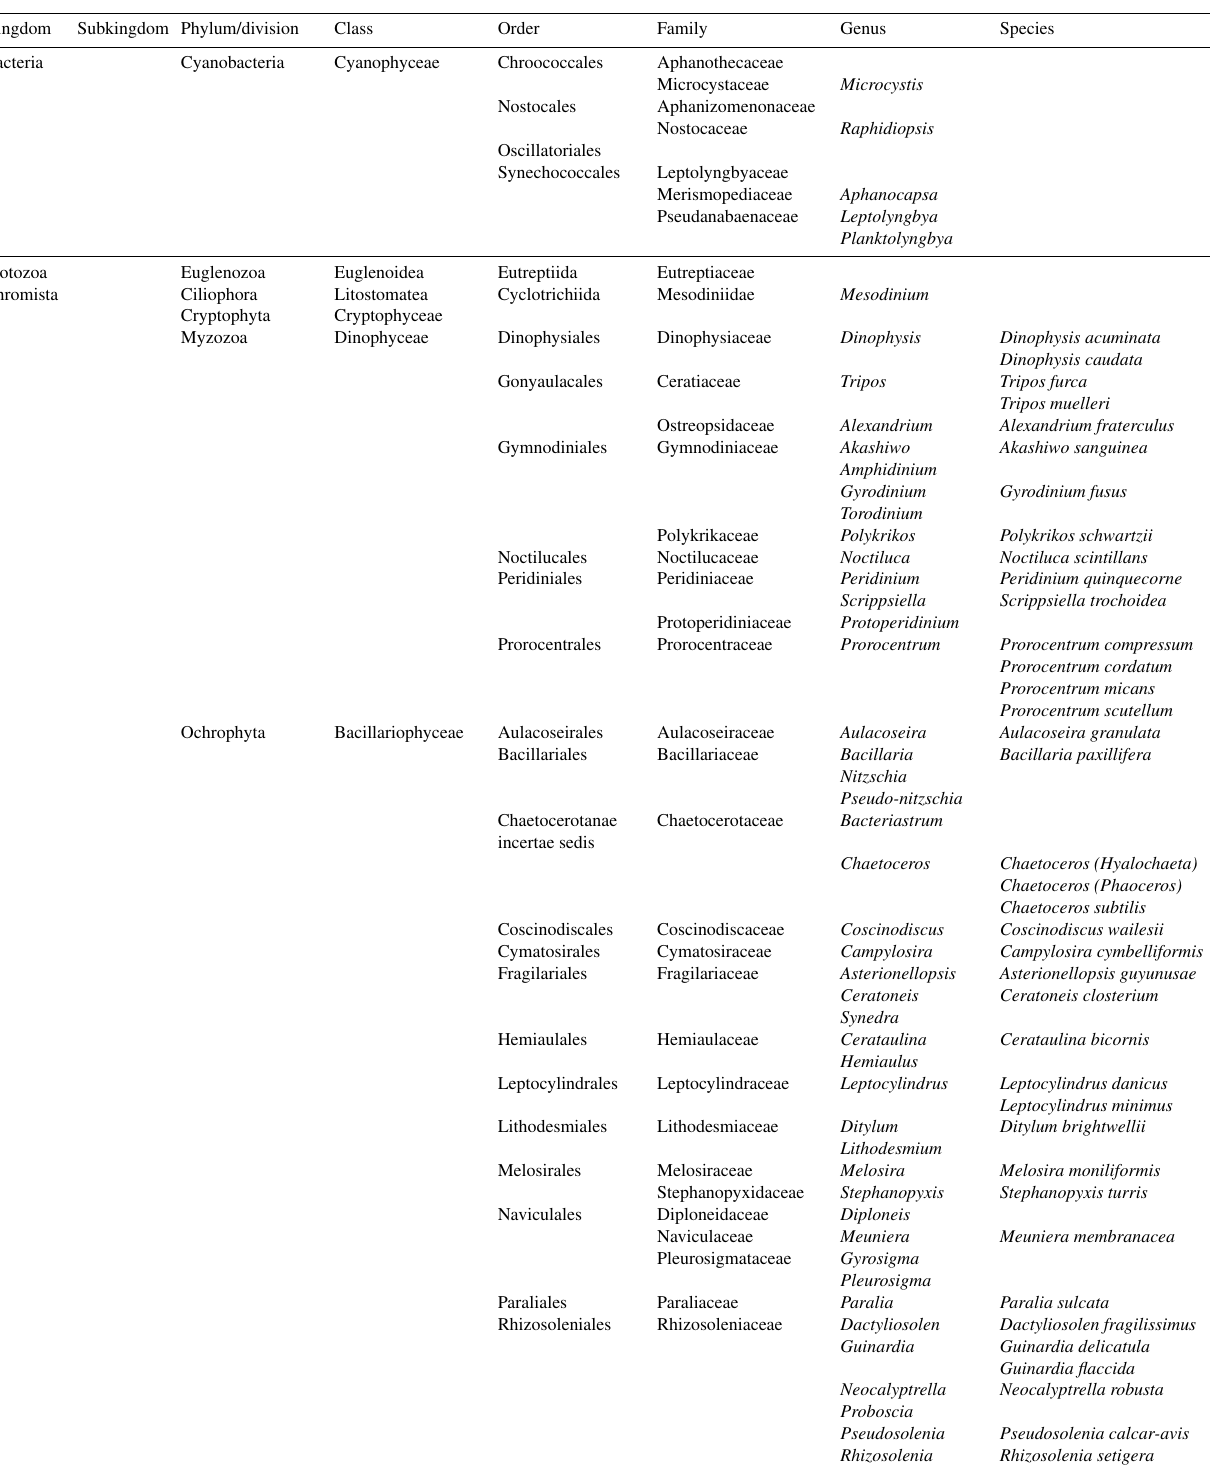
Table A1. Taxonomic coverage of the LTER-PLEA’s